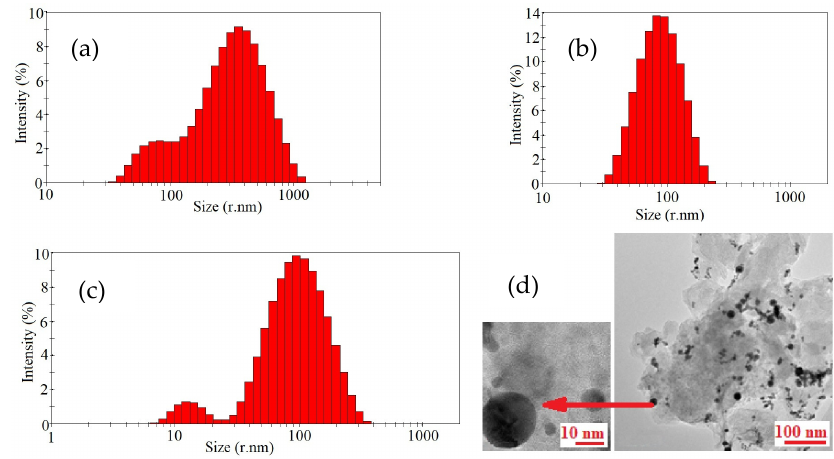
Figure 2. Histograms of particle size distribution in dispersions irradiated by nanosec laser: ShC ( a ), ShC + Au ( b ) and ShC + Ag ( c ); ( d ) TEM micrograph images of ShC + Ag hybrid prepared under nanosized laser irradiation. Insert image shows single Ag nanoparticles 20, 5, 2 nm.